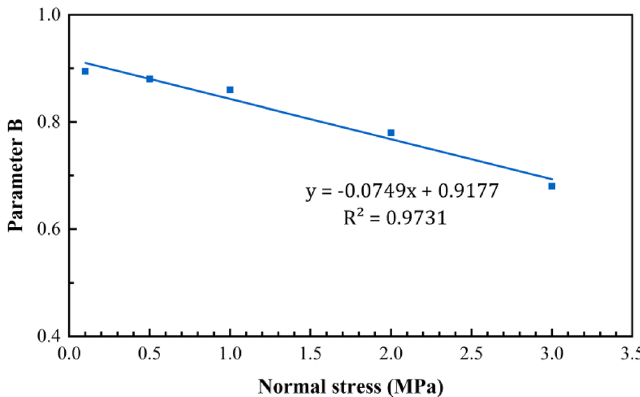
Figure 12. Trend of parameter B as a function of the normal stress.